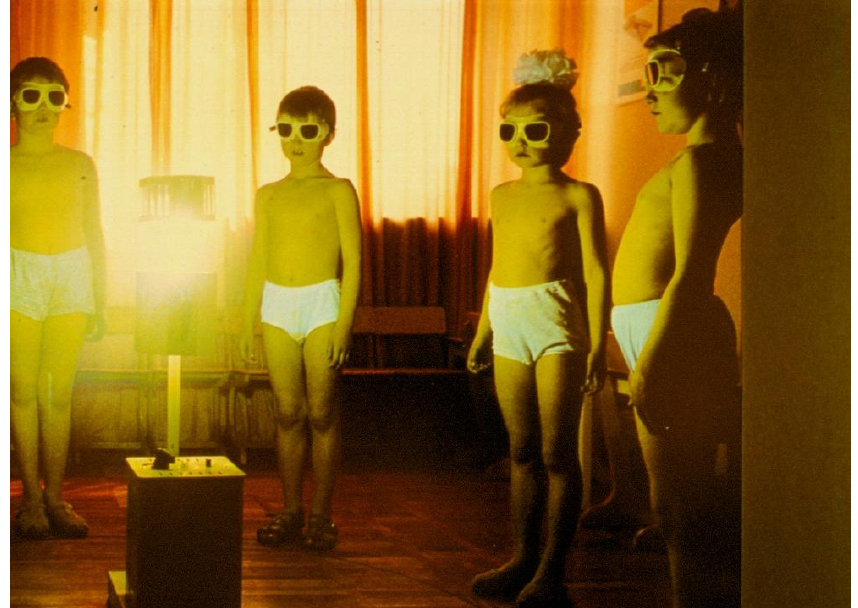
Figure 3. Irradiation of German children with quartz-mercury vapor lamps. It was recognized that the eyes should be protected from UVB